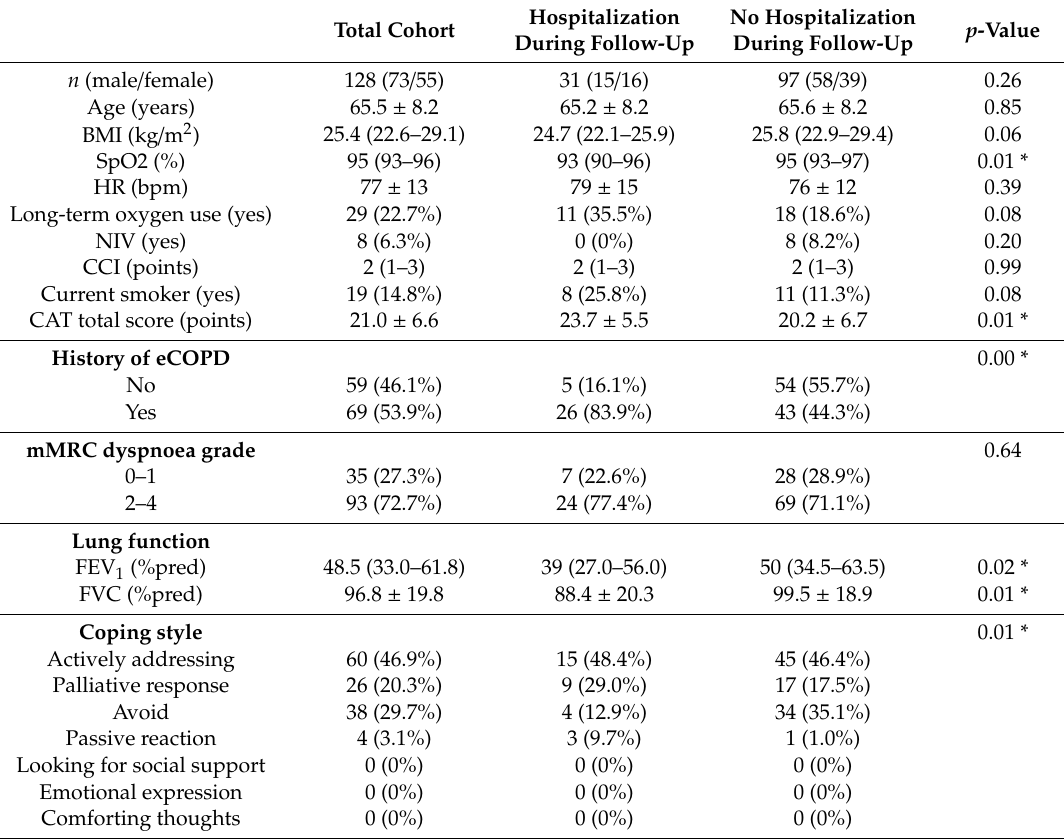
Table 2. Baseline demographic and clinical characteristics of study